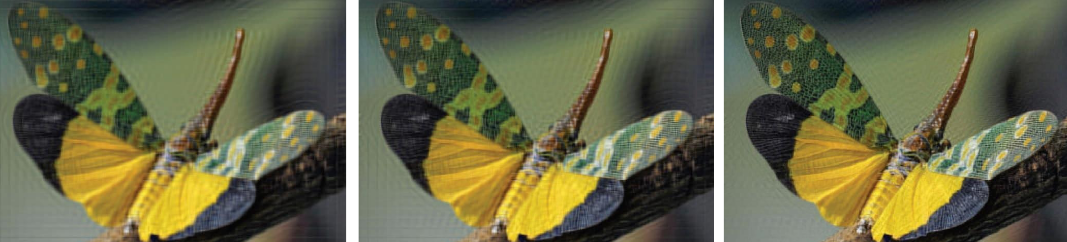
Figure 3: Rebuilt images degraded by blurred matrices M